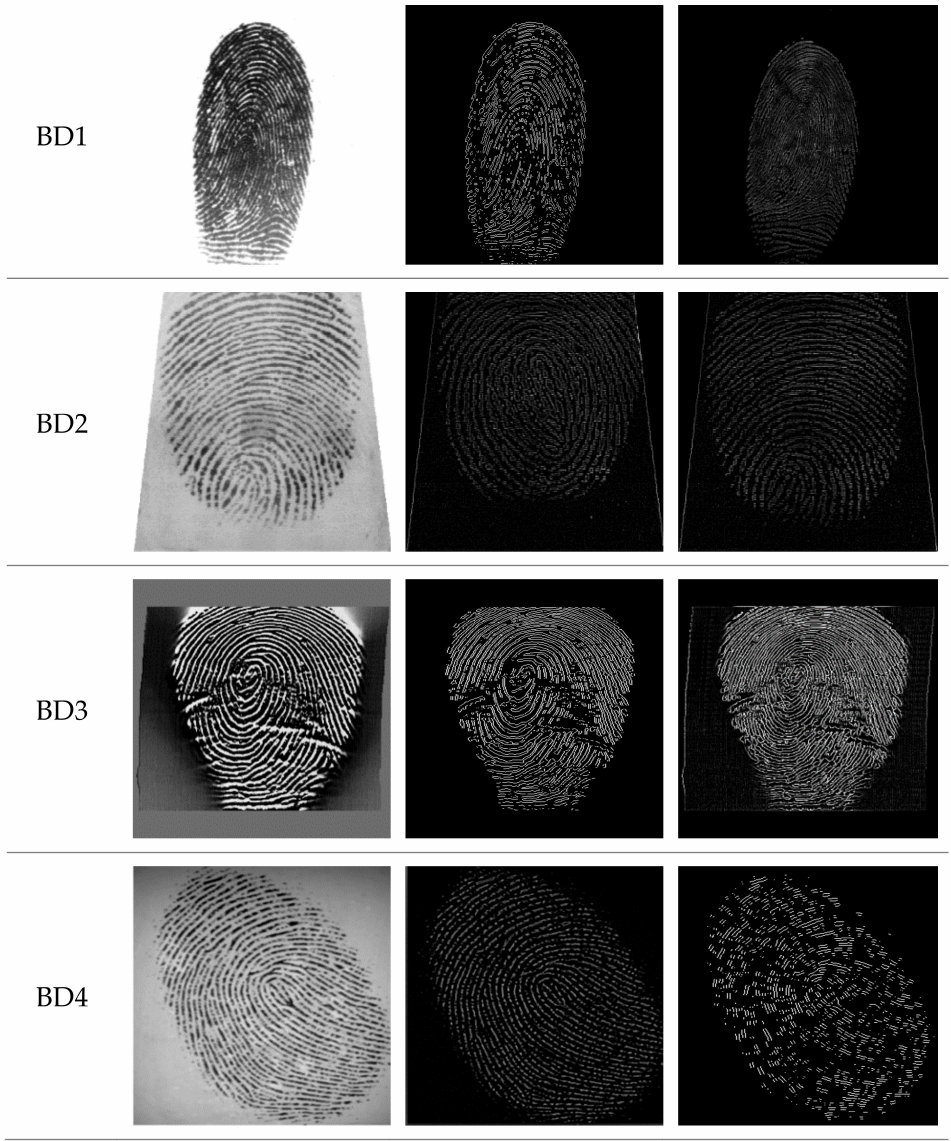
Figure 1. Samples of fingerprints from our evaluation datasets and examples of enhanced fingerprint images. Columns: left —raw grayscale images; middle —edge enhancement using the Prewitt filter; right —edge enhancement using the LoG